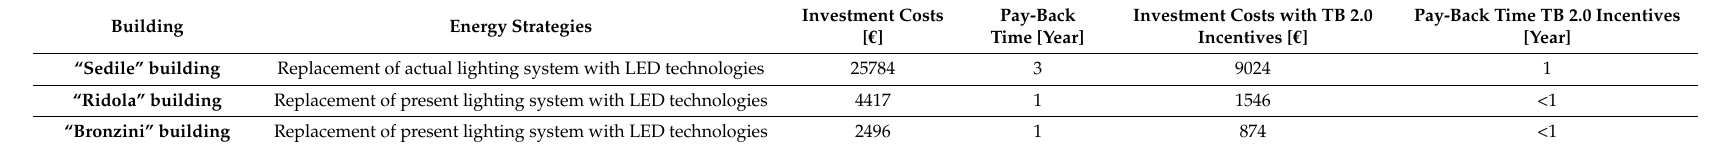
Table 16. Economic feasibility study on replacement of present lighting with LED technologies.